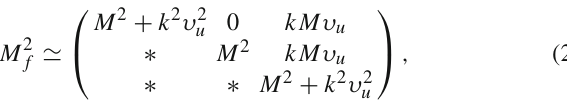
Fig. 2 The contour of Higgs mass with (cid:10) M h = as function of Yukawa coupling constant k and ratio x = 1 + m 2 / M 2 that describes the mass splitting between scalars and fermions in the VL electroweak sector. The red and black curves refer to the minimal and non-minimal VL model,